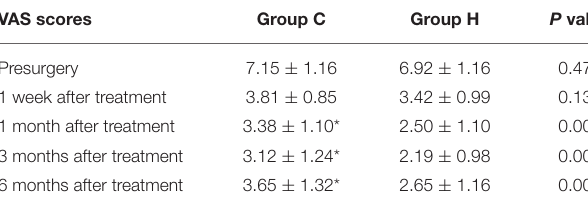
TABLE 2 | VAS scores before and after